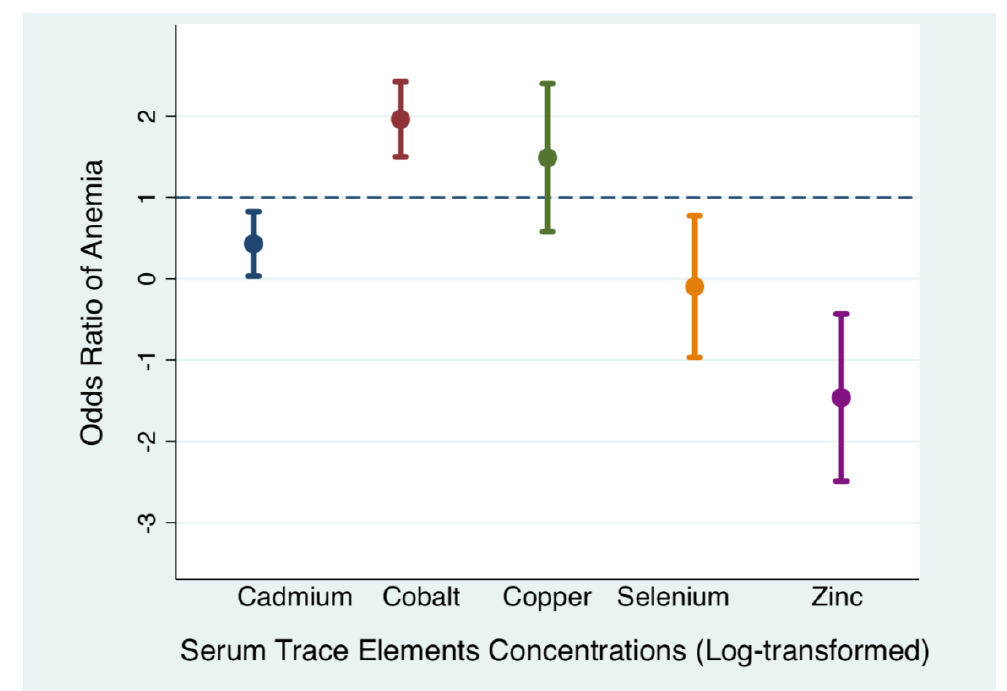
Figure 2. A regression plot to estimate the odds ratios (95% confidence intervals) of anemia by serum concentrations of cadmium, cobalt, copper, selenium, and zinc ( n = 1141).